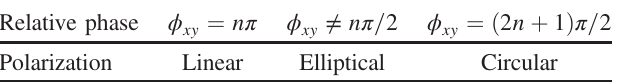
TABLE I. Three types of polarizations of ground states caused by TA phonon condensation. Below n is an integer.